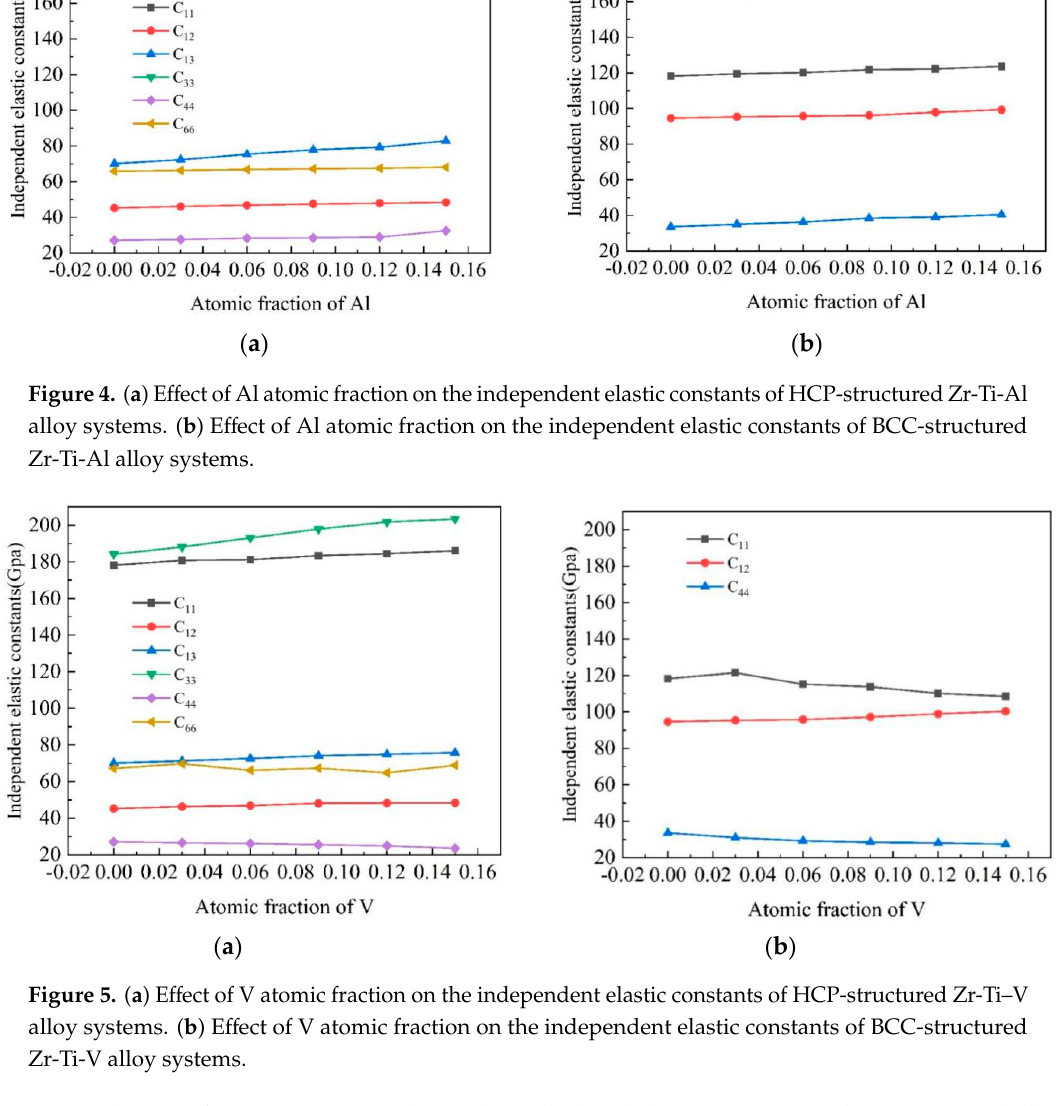
Zr-Ti-V alloy structured Zr-Ti-V alloy systems.